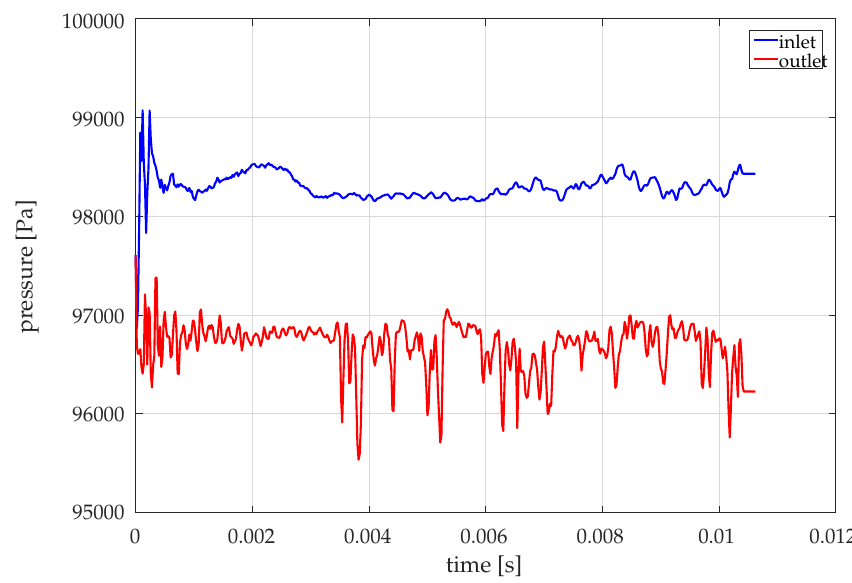
Figure 7. The fluid pressure fluctuation at the middle point of inlet Γ I and at the middle point of the outlet of the vocal tract.